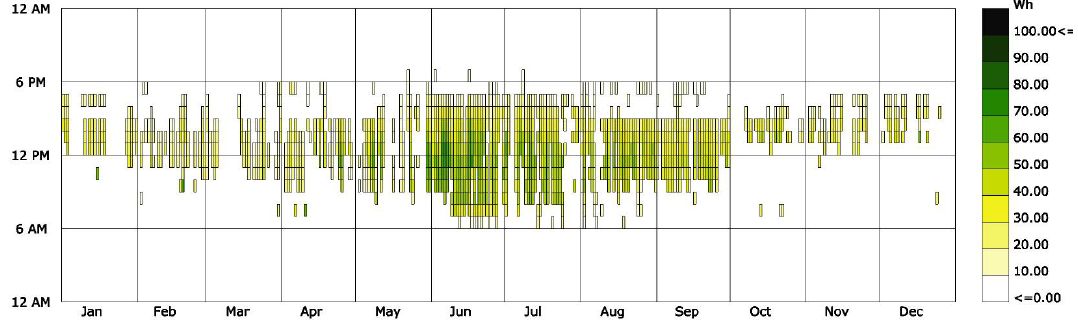
Figure 4. Hourly energy production differences of EP-Green vs. EP-Black.